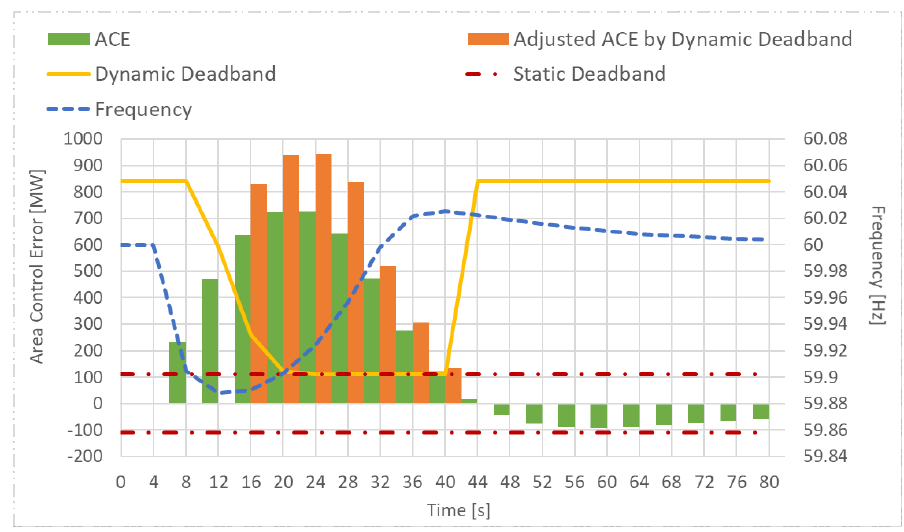
Figure 12. Verification of dynamic deadband activation.